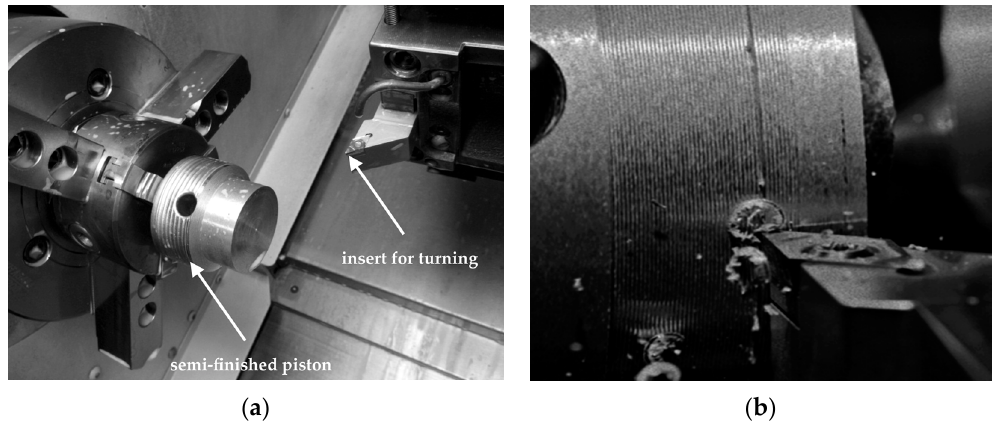
Figure 10. Touring tool life tests on piston, ( a ) tool holder; ( b ) machined surface. Table 2. Turning tool life tests parameters.